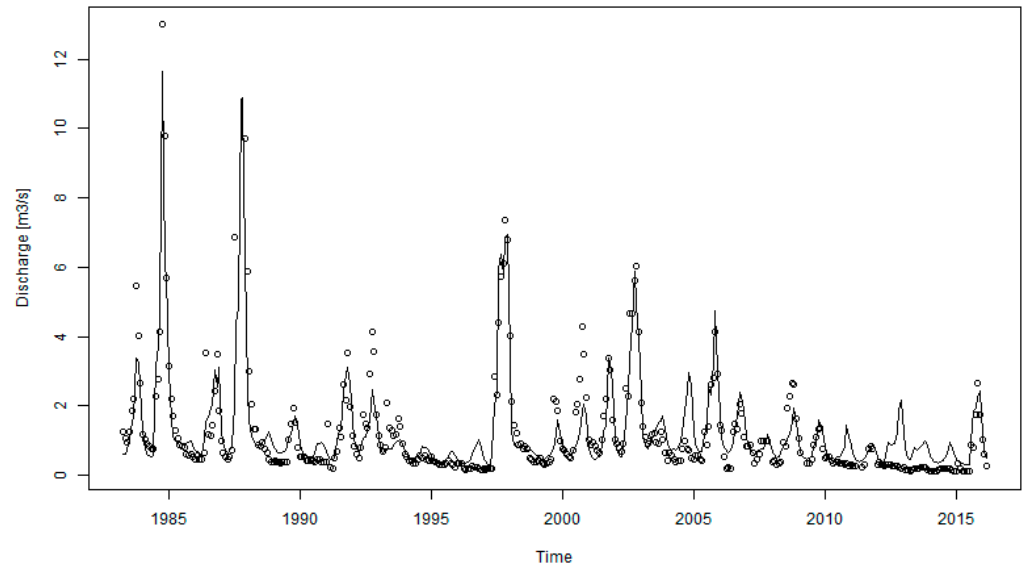
Figure 7. Hydrograph of observed and modeled streamflow in “Rio Alicahue en Colliguay” station for the simulation HRU_06. Observed discharge is shown as dots and the simulated discharge as a continuous line.